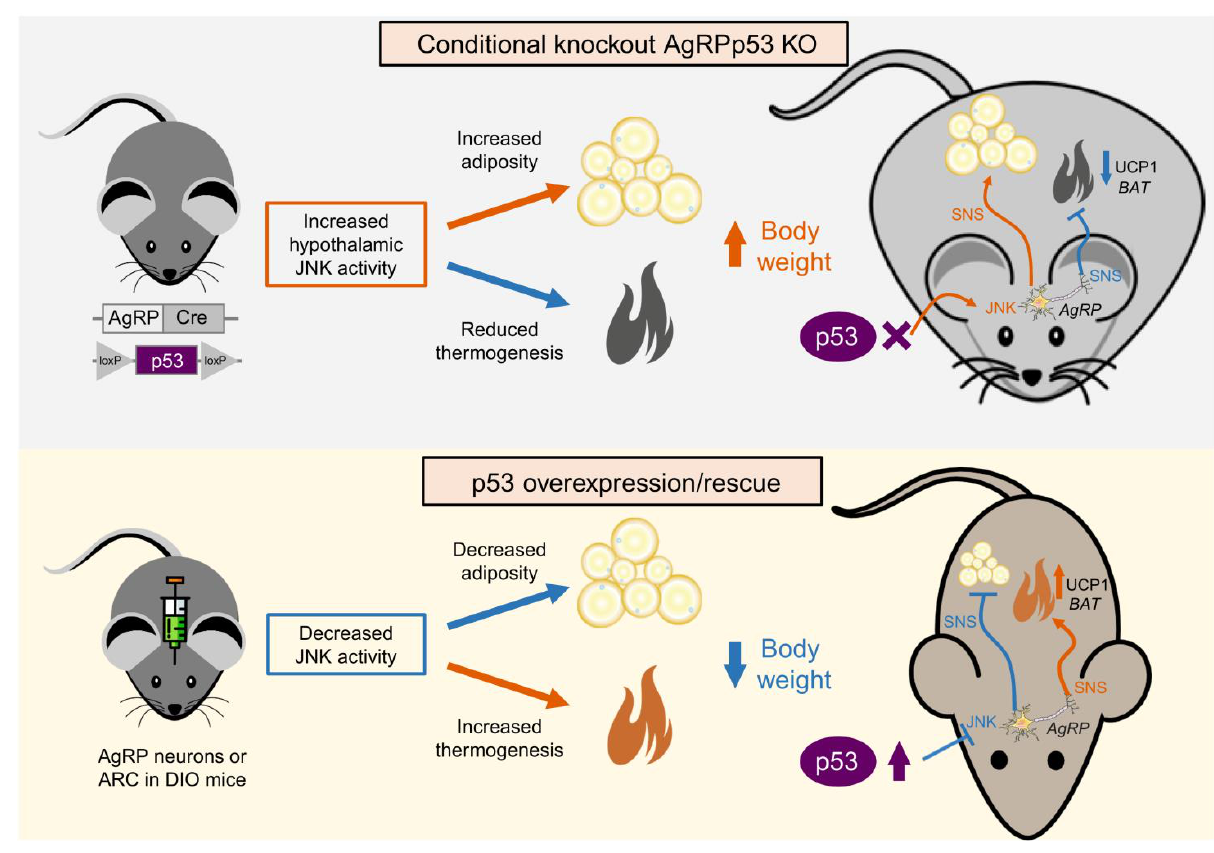
FIGURE 1: Schematic representation of the effects after ablation of p53 in AgRP neurons (upper panel) and the overexpression or rescue of p53 in AgRP neurons (lower panel). SNS, sympathetic nervous system. DIO, diet-induced obesity. UCP1, uncoupling protein 1. See text for